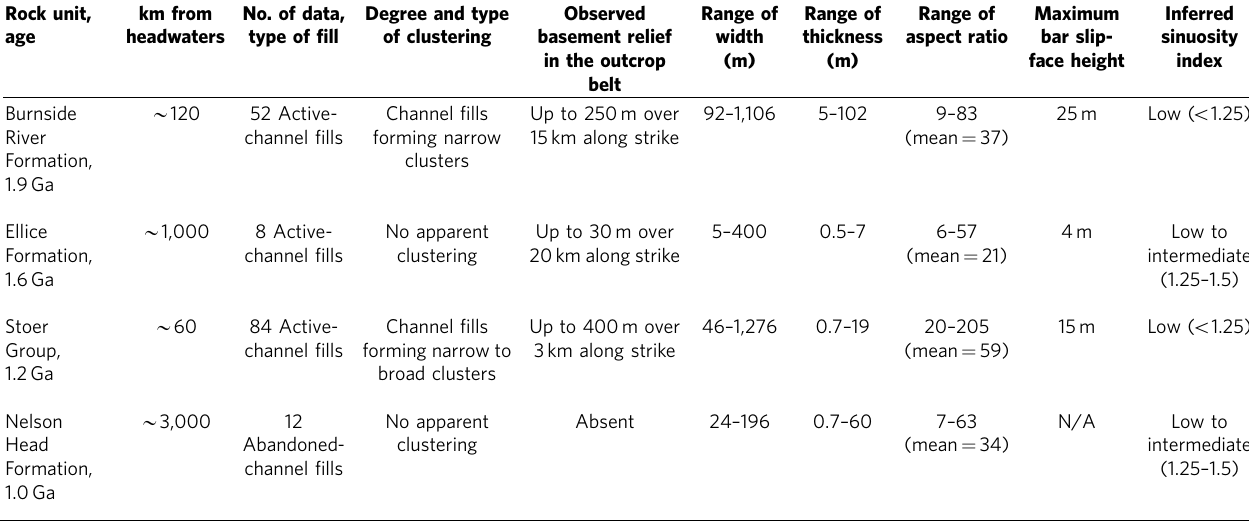
Table 1 | Salient features of the rock units considered in this study. Rock unit, km from No. of data, age headwaters type of